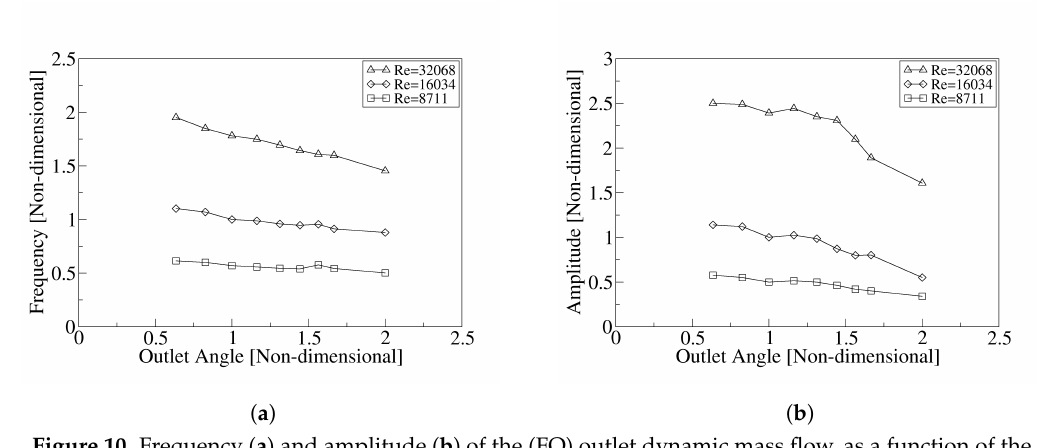
Figure 10. Frequency ( a ) and amplitude ( b ) of the (FO) outlet dynamic mass flow, as a function of the mixing chamber outlet angle and for three different Reynolds numbers, 8711, 16034 and